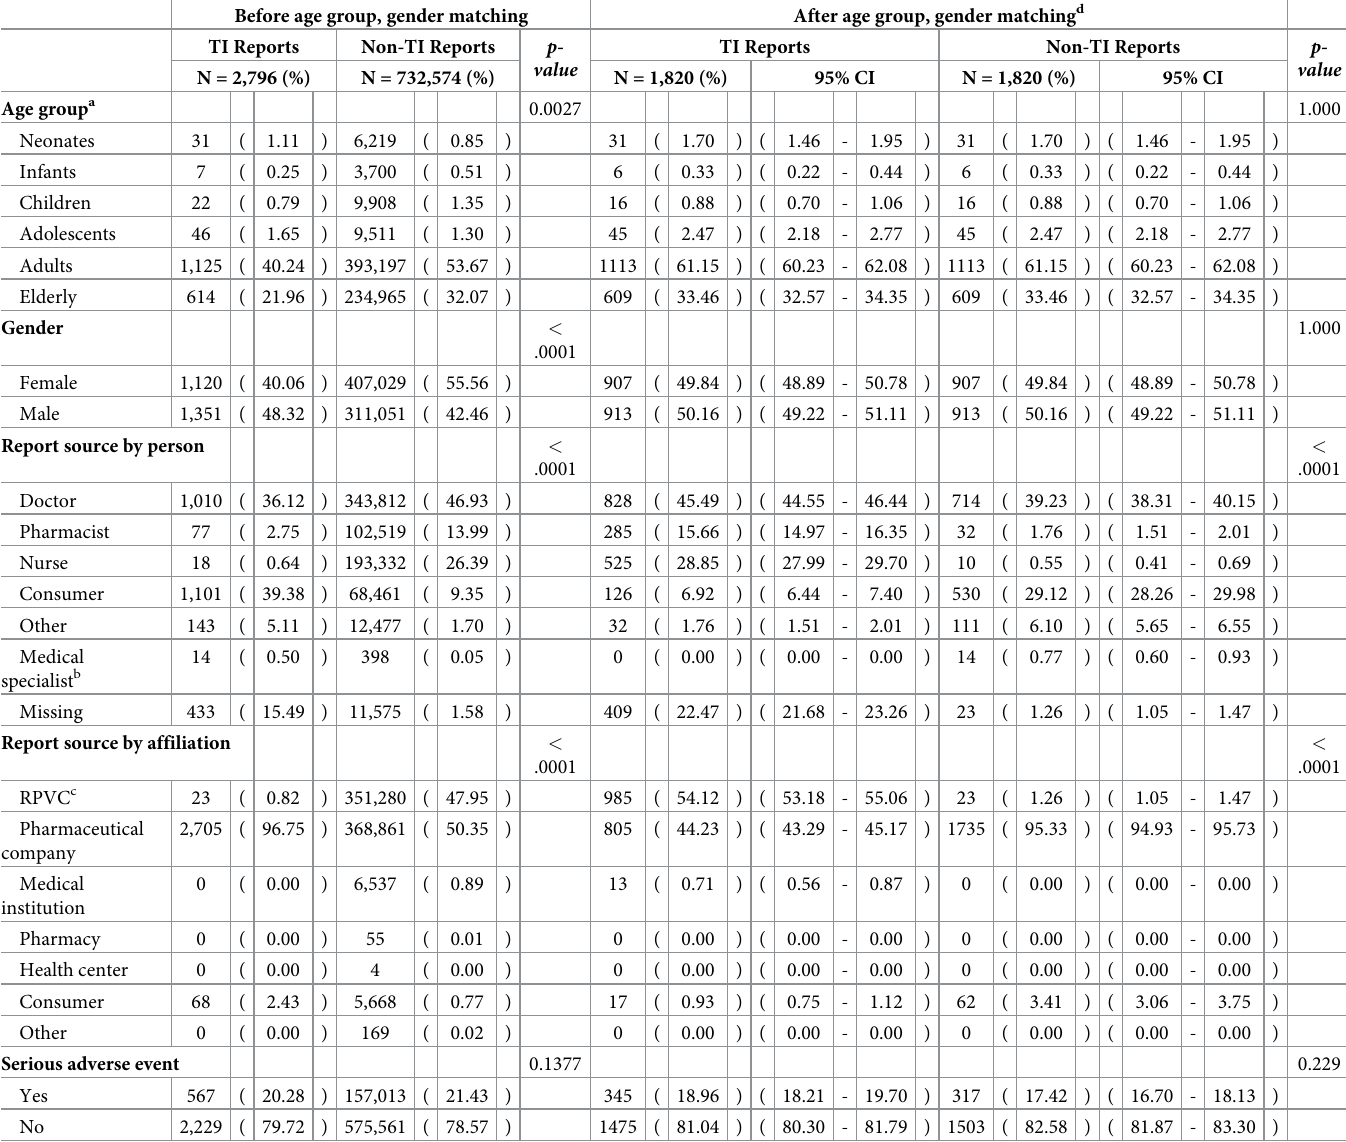
Table 1. Characteristics of therapeutic and non-therapeutic ineffectiveness applied to age group- and gender-match reports received from the KAERS database in